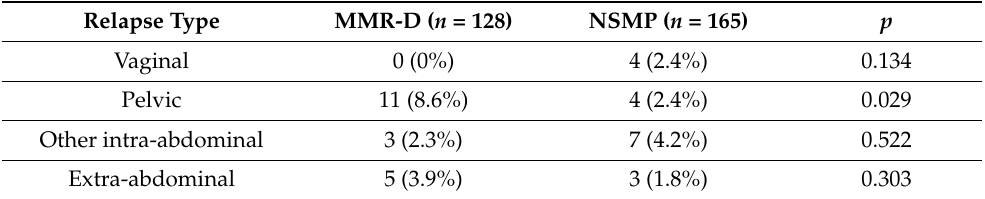
Table 5. Relapse types in stage I MMR-D and NSMP endometrial carcinomas.